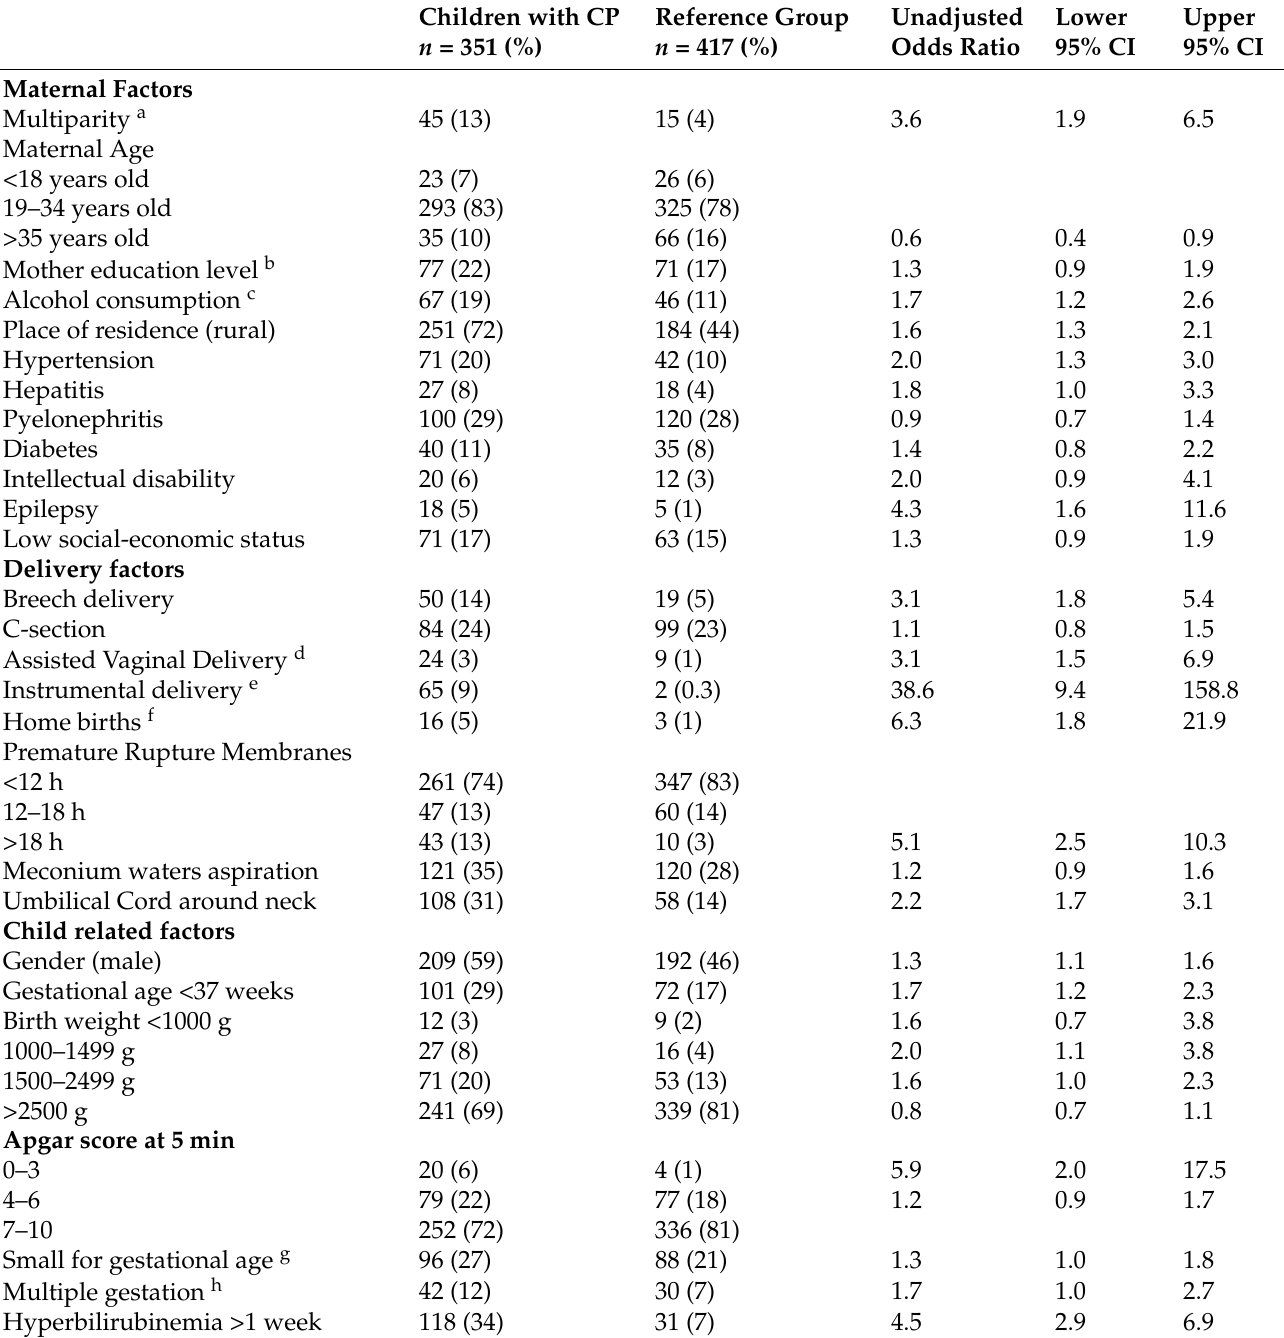
Table 3. The mother-, delivery- and child-characteristics in children with cerebral palsy (CP) and the reference group. Children with CP Reference n = 351 (%)